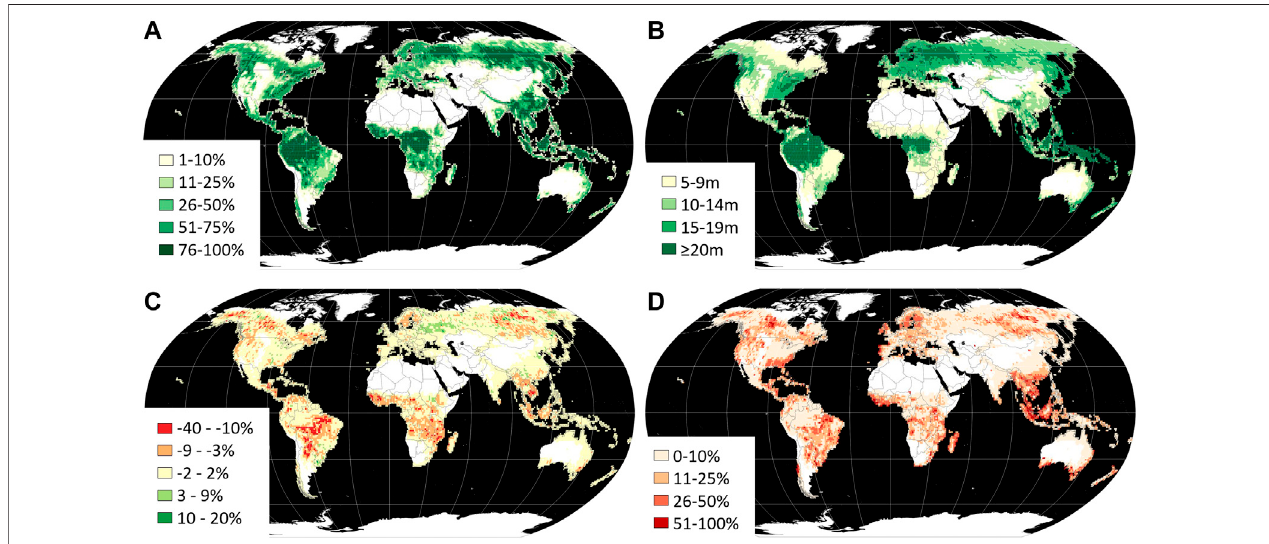
FIGURE 2 | Forest extent, structure, and dynamics for each 1 × 1 ° grid cell. (A) Forest area 2020, % cell area. Forest de fi ned as Landsat ARD pixels with ≥ 5 m canopy height. (B) Mean forest height 2020, meters. (C) Net forest area change, 2000 – 2020, % cell area. (D) Forest loss, disturbance, and degradation 2000 – 2020, % year 2000 forest area within a